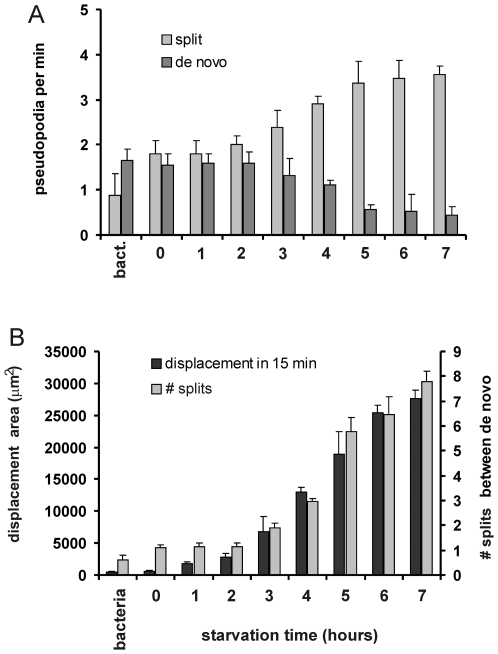
Pseudopod behavior and displacement during starvation.Wild-type AX3 cells were starved for the indicated time. The frequencies of split and de novo pseudopodia are presented in panels A. The number of split pseudopodia in between two de novo pseudopodia, and the displacement during 15 minutes is presented in panels B. The data show the means and standard deviations of 30 cells from at least two independent movies. See supplemental information Table S1 for additional data.